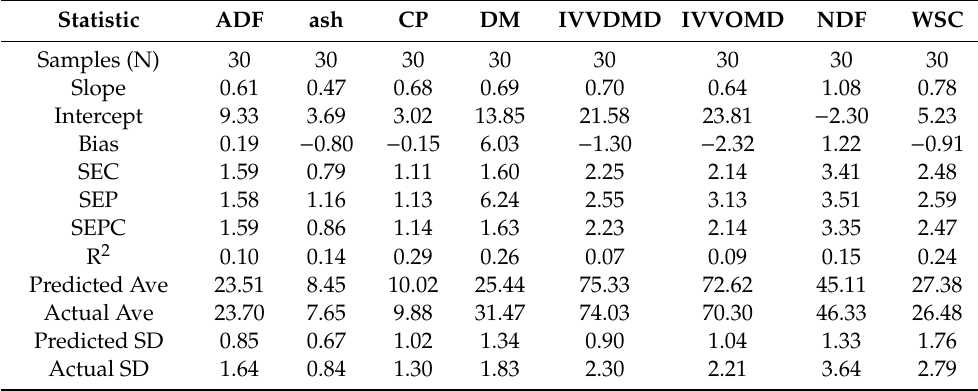
Table 4. Descriptive statistics for comparing lab results to model predictions of 30 samples from 30 November 2018 (plants in reproductive phase) using the above models. This includes the slope of the regression line, the y-intercept, the Bias, standard error of covariance (SEC), standard error of prediction (SEP) and standard error of prediction covariance (SEPC), the coe ffi cient of determination (R 2 ), the predicted and actual average, and the predicted and actual standard deviation (SD).